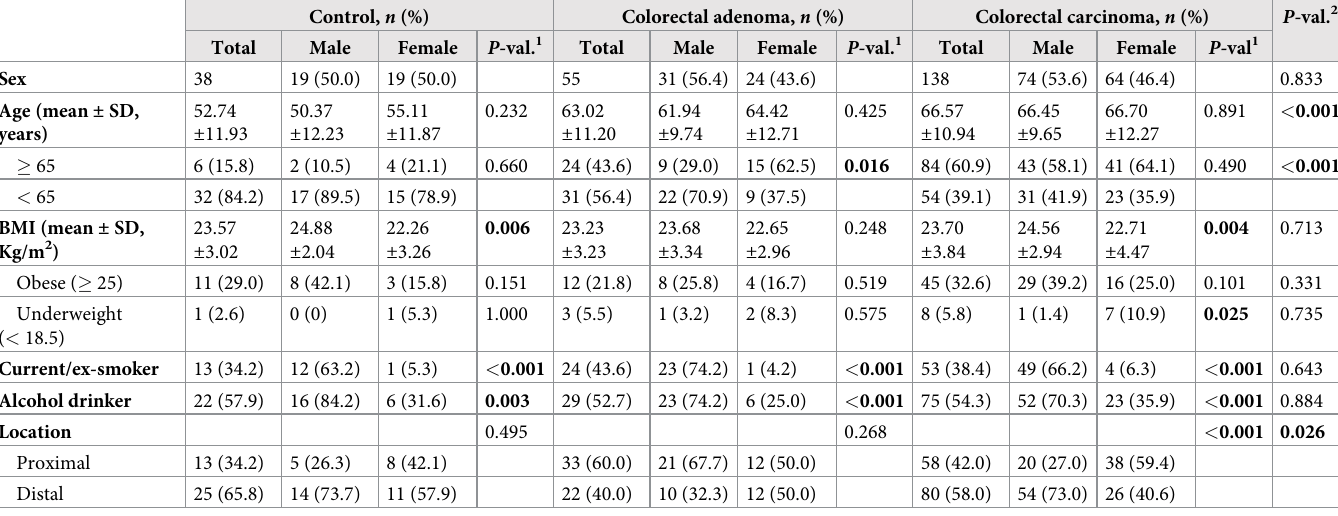
Table 1. Baseline characteristics of the study cohort in control, colorectal adenoma, and colorectal carcinoma.